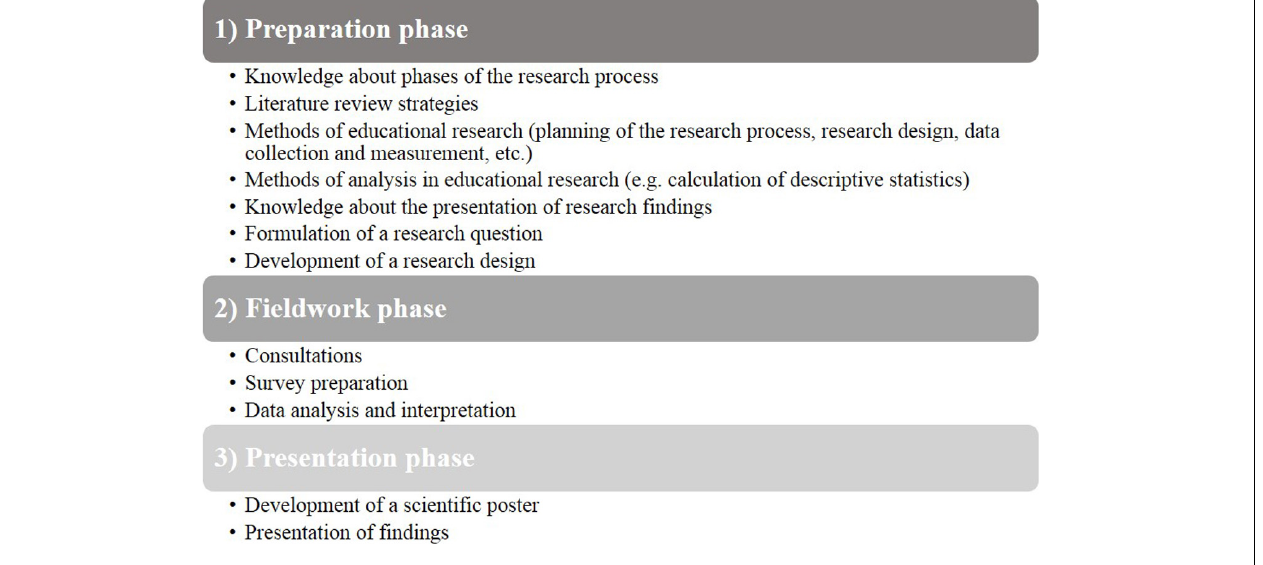
FIGURE 2 | The three phases of a research-learning project (RLP).